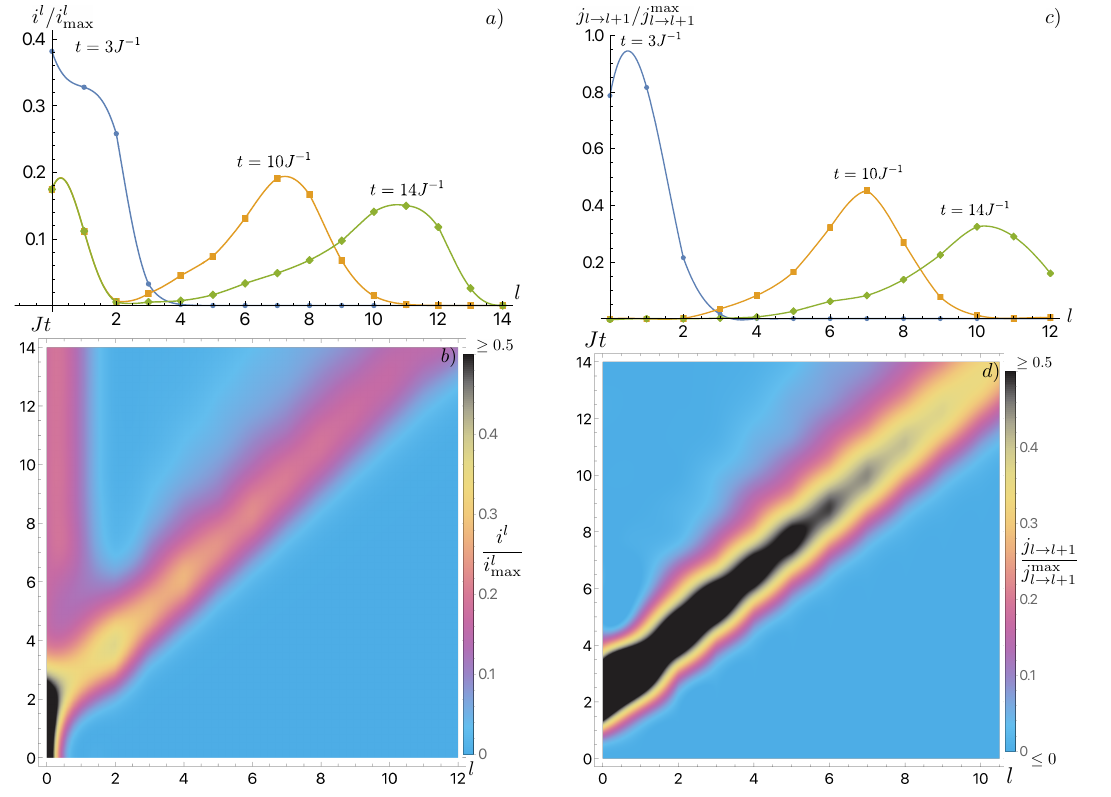
Figure 4: Time-evolution of information in the transverse- and longitudinal-field = 2 | ↑〉〈↑ | + 1 | ↓〉〈↓ | as ini- Ising model with the infinite product state with ρ n 3 3 tial state. a) The information lattice values i l as a function of l at three different = 5 / 3 − log ( 3 ) ( n is times in units of the maximum information lattice value i l 2 max suppressed due to translation invariance). At t = 3 J − 1 (blue dots), nearly all the information remains local at scales l < 4. At t = 10 J − 1 (orange squares) two peaks have formed with almost zero information in between (note that up to l = 2 the green curve lies directly on top of the orange curve obscuring its view). As the sys- tem continues to evolve at t = 14 J − 1 (green diamonds) the information for l ≤ 2 has essentially stabilized to its infinite-time value while the peak at long range trav- els to larger and larger scales. b) The information lattice values i l for a time con- tinuum. Notice the gap between the information localized at the smallest scales and the peak traveling to larger and larger scales which is beginning to form slightly after t = 6 J − 1 . c) The total information-current per site j in units of the maximum l → l + 1 ≈ 0.021. d) The total information-current for a time continuum. (In current j max l → l + 1 all plots the values at non-integer l , obtained by a third order spline interpolation, are added as a guide to the